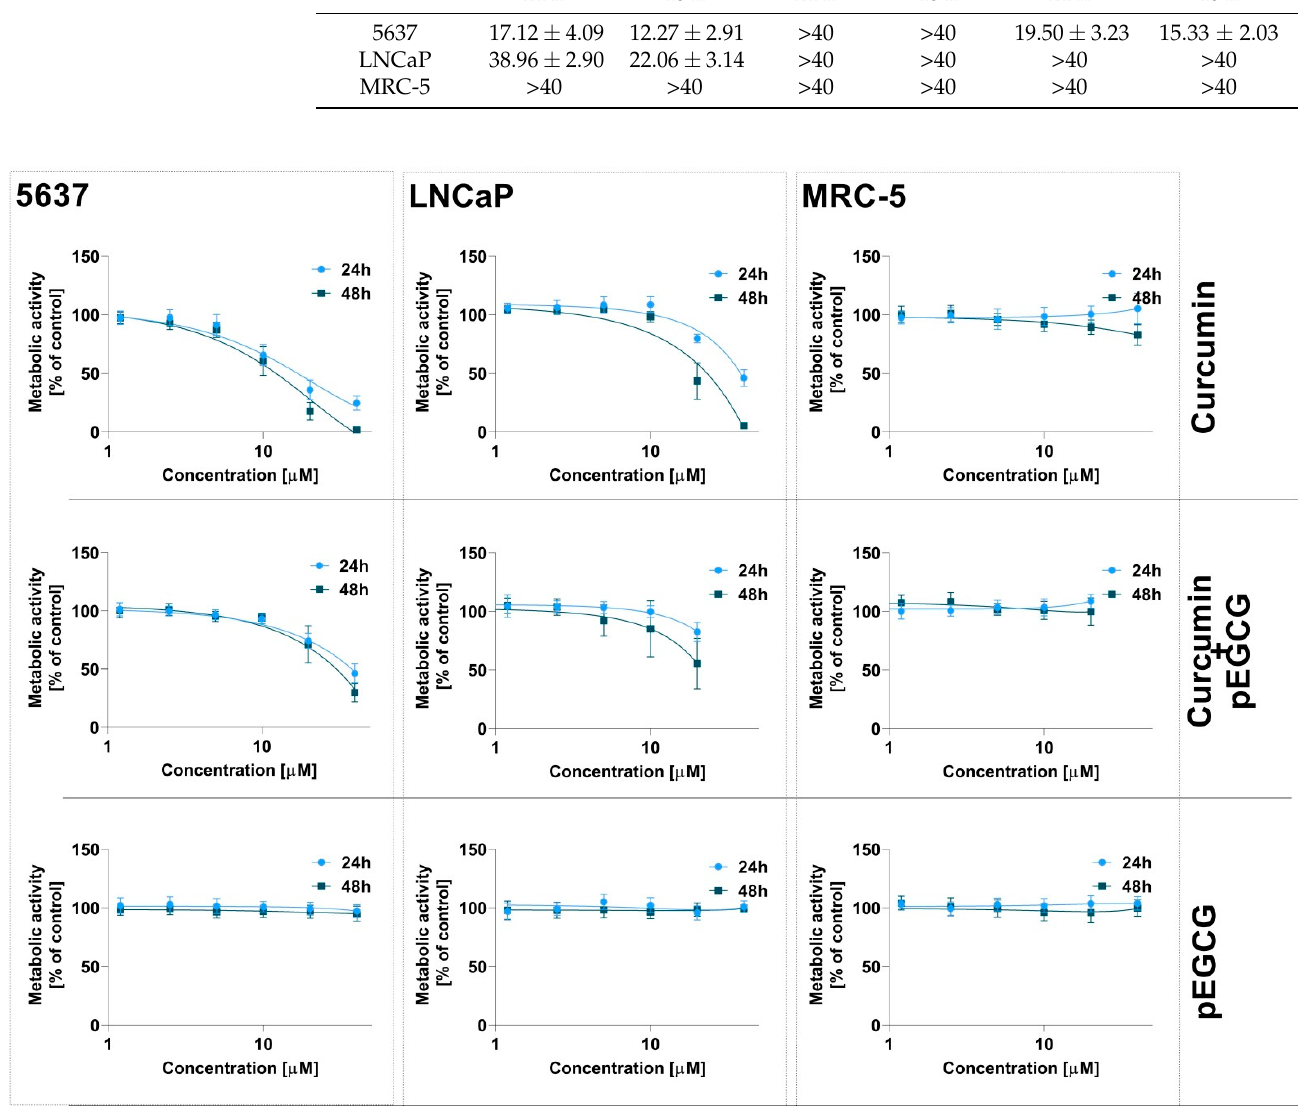
Figure 7. The cytotoxic activity of liposomal formulation containing curcumin, pEGCG, and their combination against 5637, LNCaP, and MRC-5 cells. Data are expressed as the mean ± SD from three independent experiments.